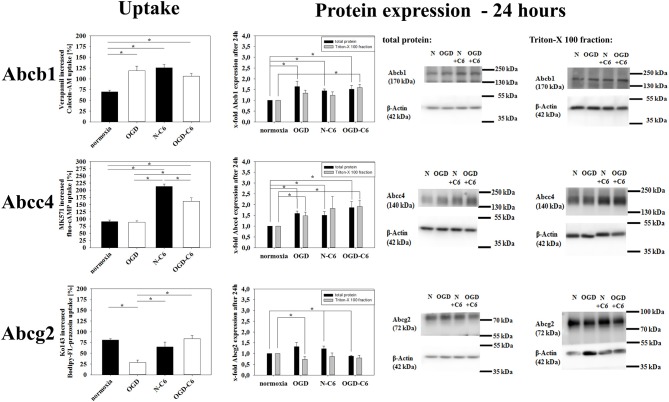
Influence of 4 h oxygen/glucose deprivation (OGD) treatment with subsequent 20 h reoxygenation phase and presence of astrocyte soluble factors on Abc-transporter activity and protein expression. On the left side results of uptake assays with specific substrates for Abcb1 (calcein-AM), Abcc4 (fluo-cAMP), and Abcg2 (Bodipy-FL-prazosin) are presented. In the middle densitometric analysis derived from western blots of total protein cell lysates as well as Triton-X 100 membrane enriched fractions are shown, on the right side according representative western blot images are depicted. N, cerebEND normoxic control; OGD, cerebENDs treated under OGD conditions for 4 + 20 h reoxygenation/renutrition; N−C6 or N+C6, cerebENDs treated for 24 h with C6 conditioned medium derived from C6 cells which were treated under normoxic control conditions for 4 h; OGD−C6 or OGD+C6, cerebENDs treated for 4 h OGD with C6 conditioned medium derived from C6 cells which were treated under OGD conditions for 4 h with a subsequent incubation of cerebENDs for 20 h with N−C6 medium. Statistical significance was labeled with *(p < 0.05, two-sided student's t-test with same variances). Data are presented as means ± s.e.m. (n = 8–16 for uptake assays, n = 4–6 for protein expression data).